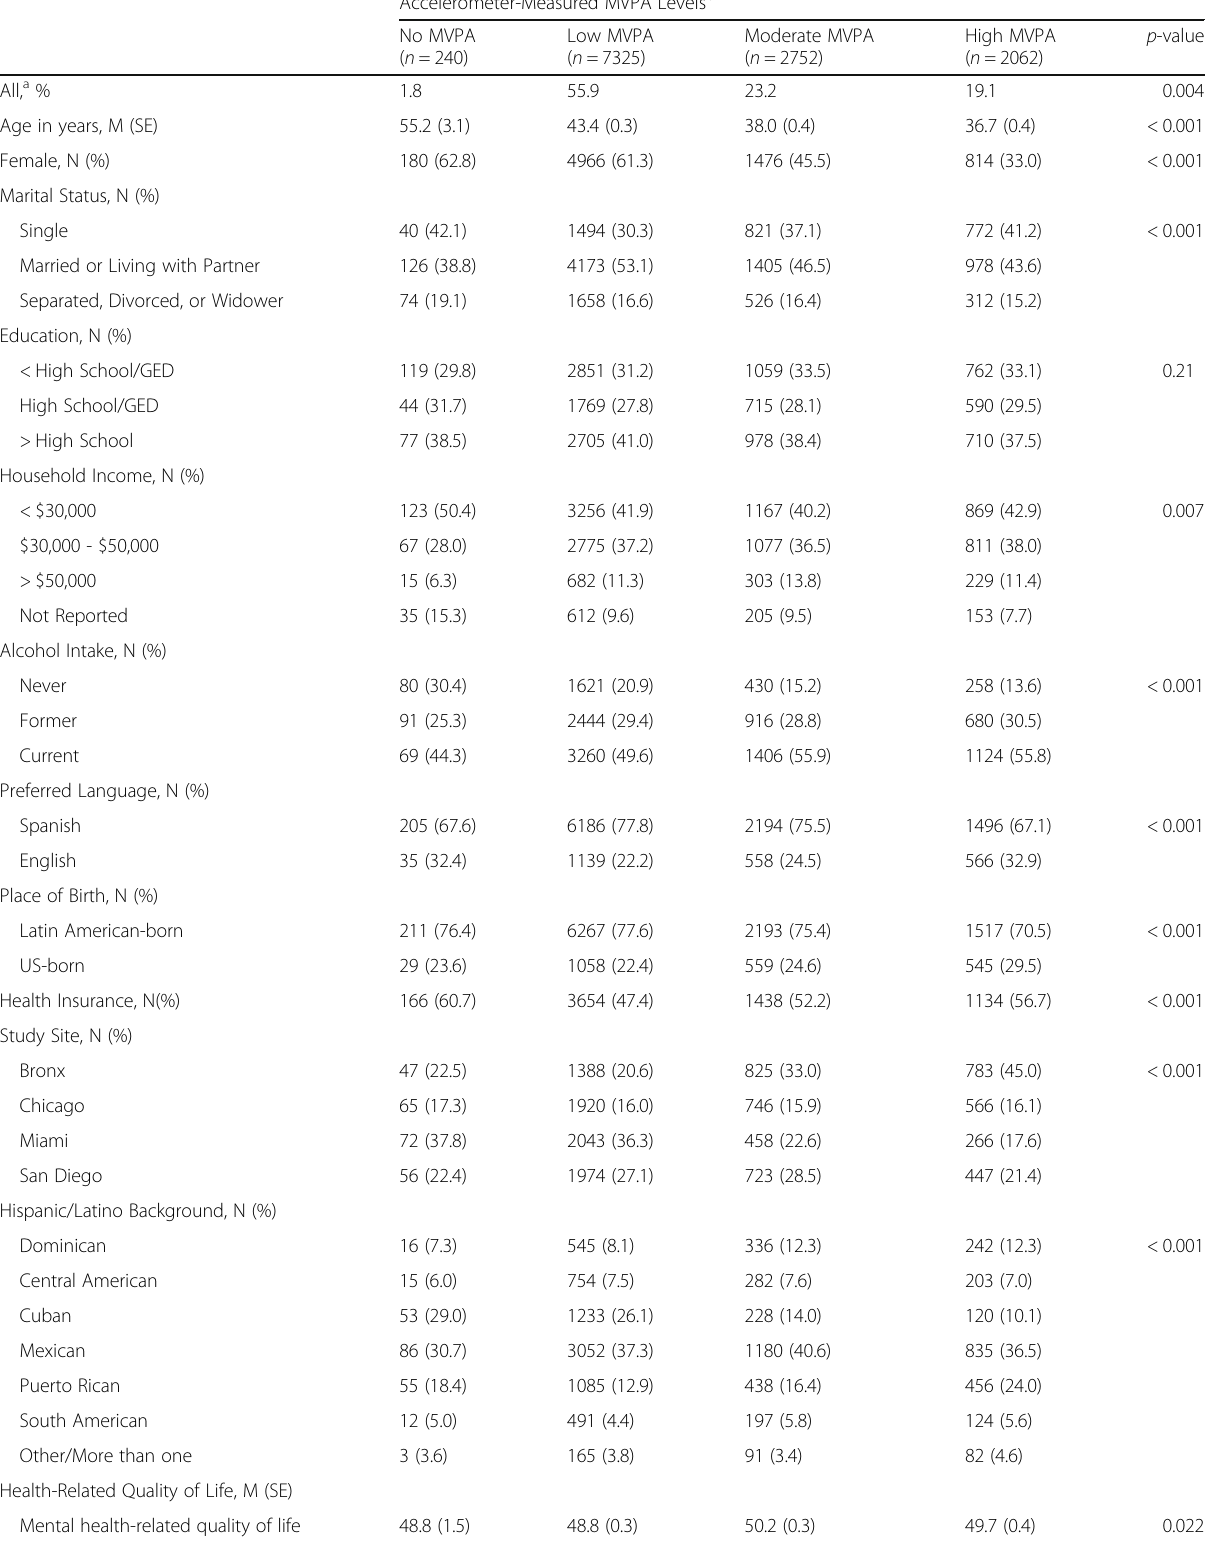
Table 1 Age-adjusted characteristics for Hispanic/Latino adults by accelerometer-measured MVPA levels: